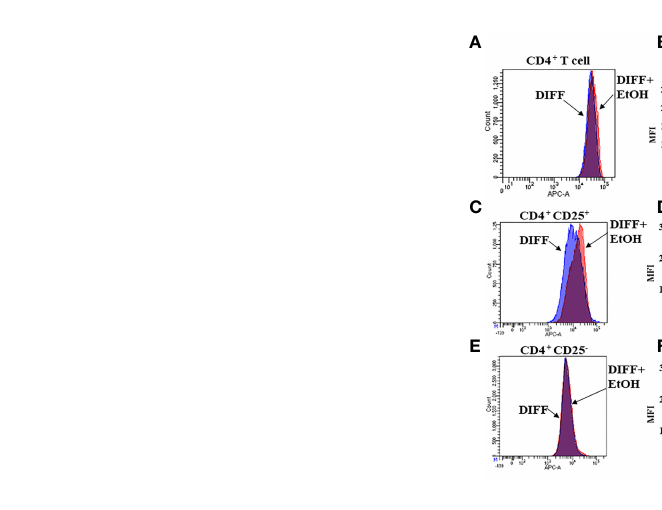
FIGURE 7 | Mitochondrial volume of CD4 + T cells. (A) Representative FACS histogram of Mitotracker Deep Red staining of DIFF and DIFF + EtOH CD4 + T cells. (B) Ethanol increased the MFI of Mitotracker Deep Red in differentiated CD4 + T cells. (C) Representative FACS histogram of Mitotracker Deep Red staining of DIFF and DIFF + EtOH CD4 + CD25 + (enriched Treg) cells. (D) Ethanol increased the MFI of Mitotracker Deep Red in enriched Treg cells. (E) Representative FACS histogram of Mitotracker Deep Red staining of DIFF and DIFF + EtOH CD4 + CD25 - (enriched Th1) cells. (F) There were no signi fi cant differences in MFI of enriched Th1 cells. MFI = mean fl uorescent intensity, Naïve = undifferentiated and no ethanol treatment, EtOH = undifferentiated and ethanol-treated, DIFF = differentiated cells and no ethanol treatment, and DIFF + EtOH = differentiated and ethanol-treated. Data represents average values using PBMCS from 6 donors expressed as mean ±